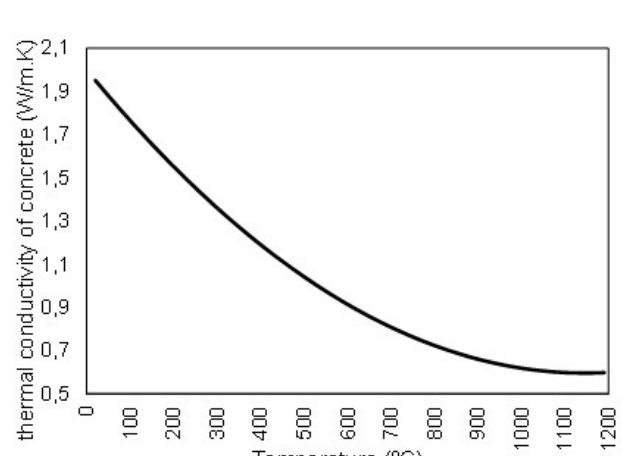
Figure A4 – Density of concrete